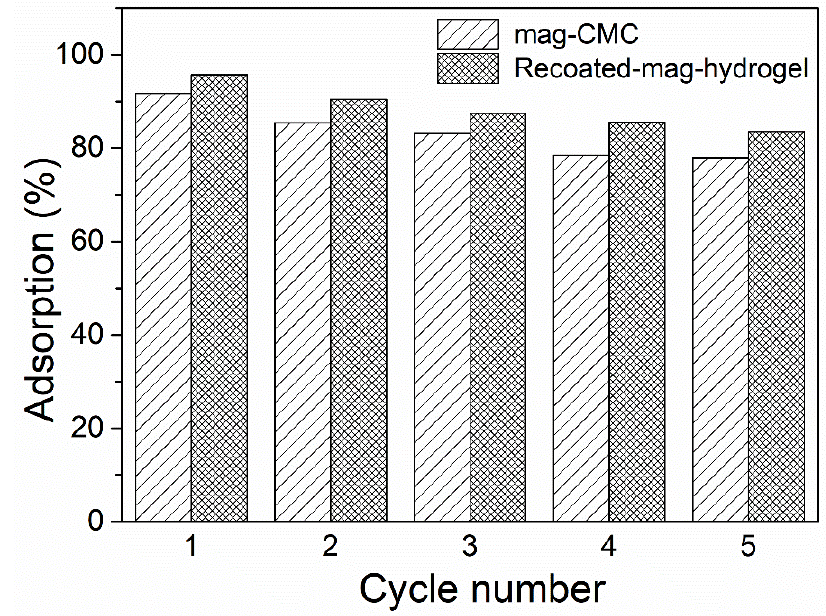
Figure 14. Schematic diagram of proposed interactions between mag-hydrogel and MB dye.